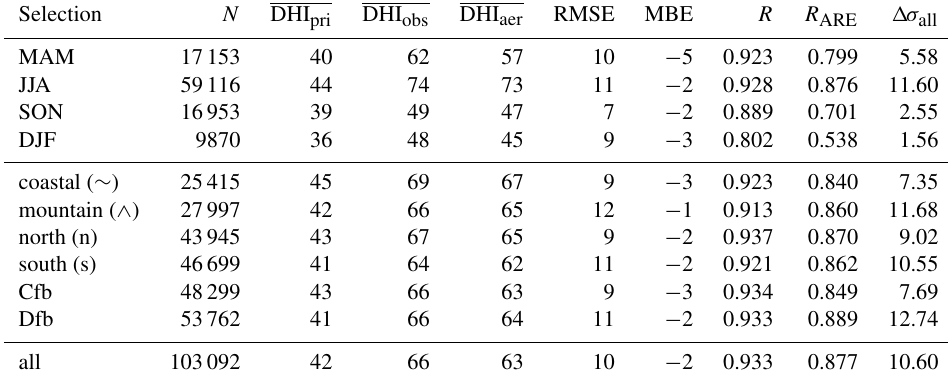
Table 7. Same as Table 5 but for diffuse horizontal irradiance